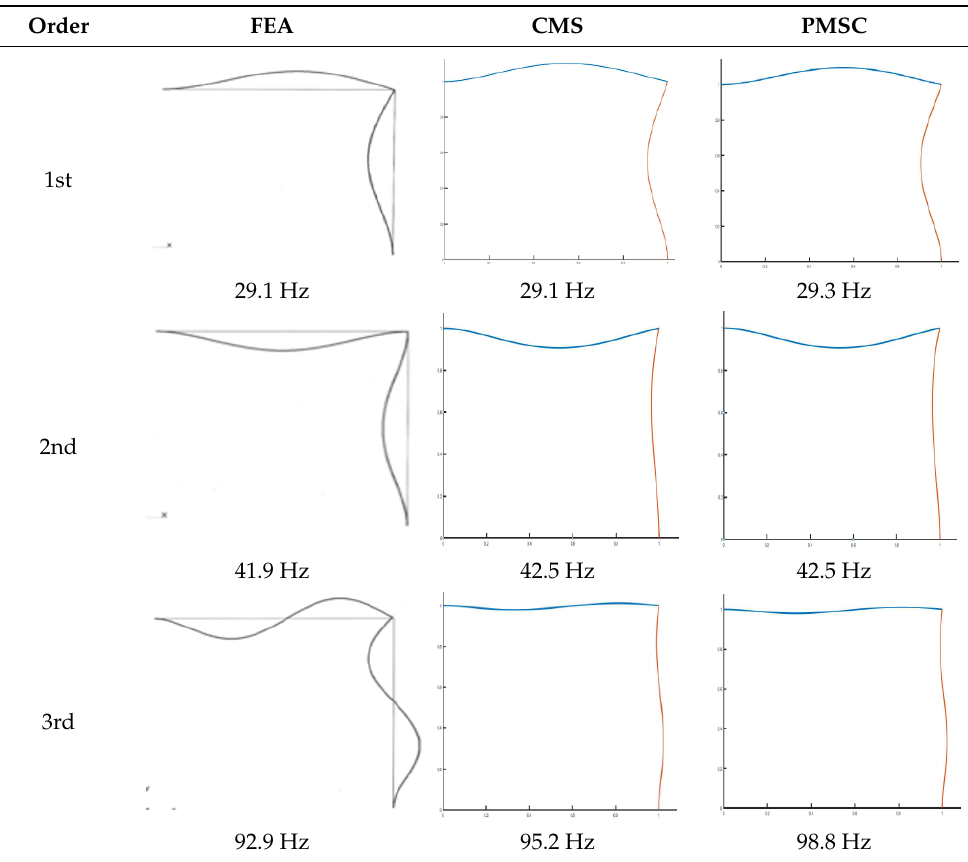
Table 11. The mode shape for each length ratio (L A :L B = 1:0.5).